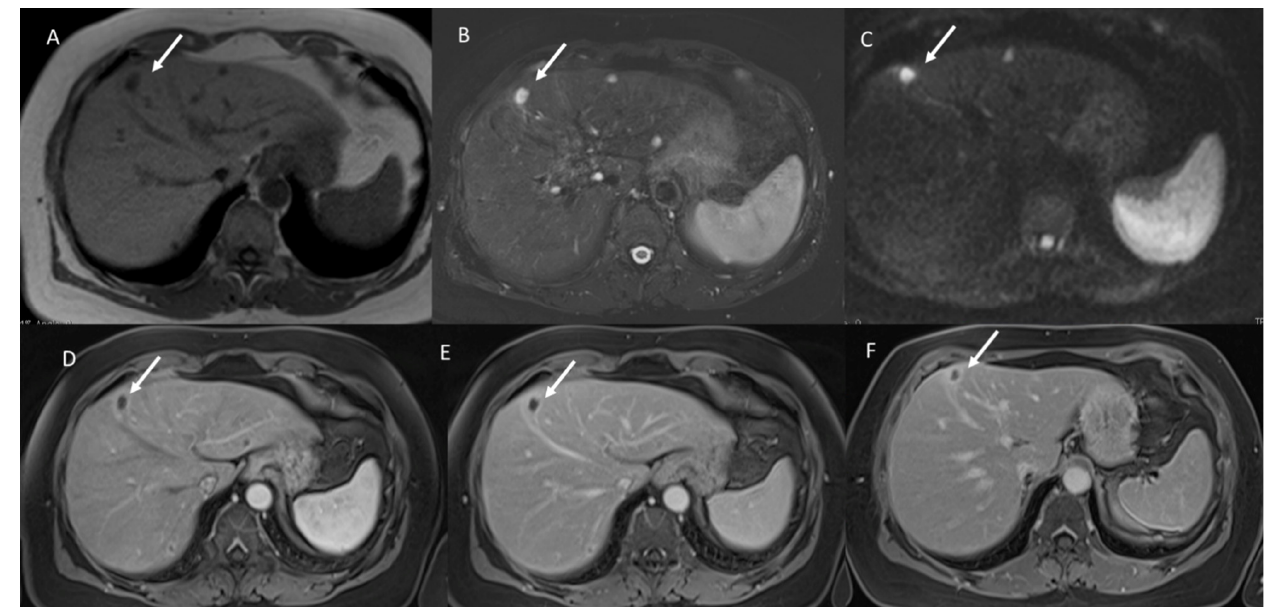
Figure 1. Mucinous liver metastasis on IV hepatic segment (arrow). In ( A ) T1-W image, the lesion shows hypointense signal. In ( B ), the lesion shows very high SI in T2-W and restricted diffusion in b800 s/mm 2 ( C ). During contrast study (( D ) arterial phase, ( E ) portal phase and ( F ) equilibrium phase), the lesion shows Rim APHE in all phases.